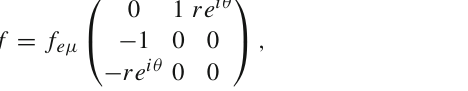
a unitary field redefinition on the L μ,τ and e Ri fields. Note that such field redefinitions affect neither the form of the anti- symmetric coupling matrix f nor the form of gauge charged currents. The former keeps its antisymmetric